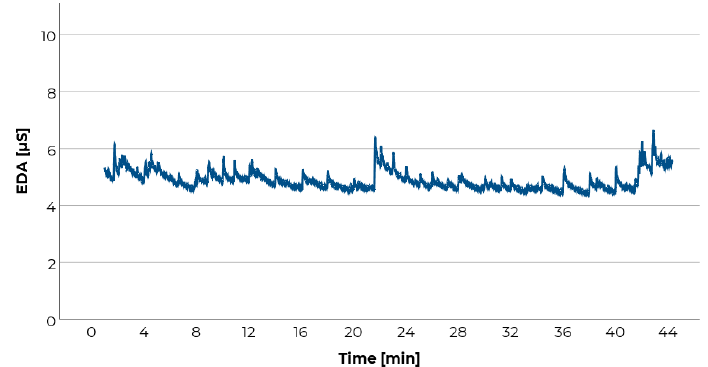
Figure 6. Exemplary raw electrodermal activity (EDA) data of a participant during a 44-min drive as a passenger on a German Autobahn. The numerous peaks in the chart indicate external events like braking, participant’s movements, and motion sickness rating procedures. Since these events are not necessarily related to motion sickness in a naturalistic test setting, these peaks should be considered as artifacts.